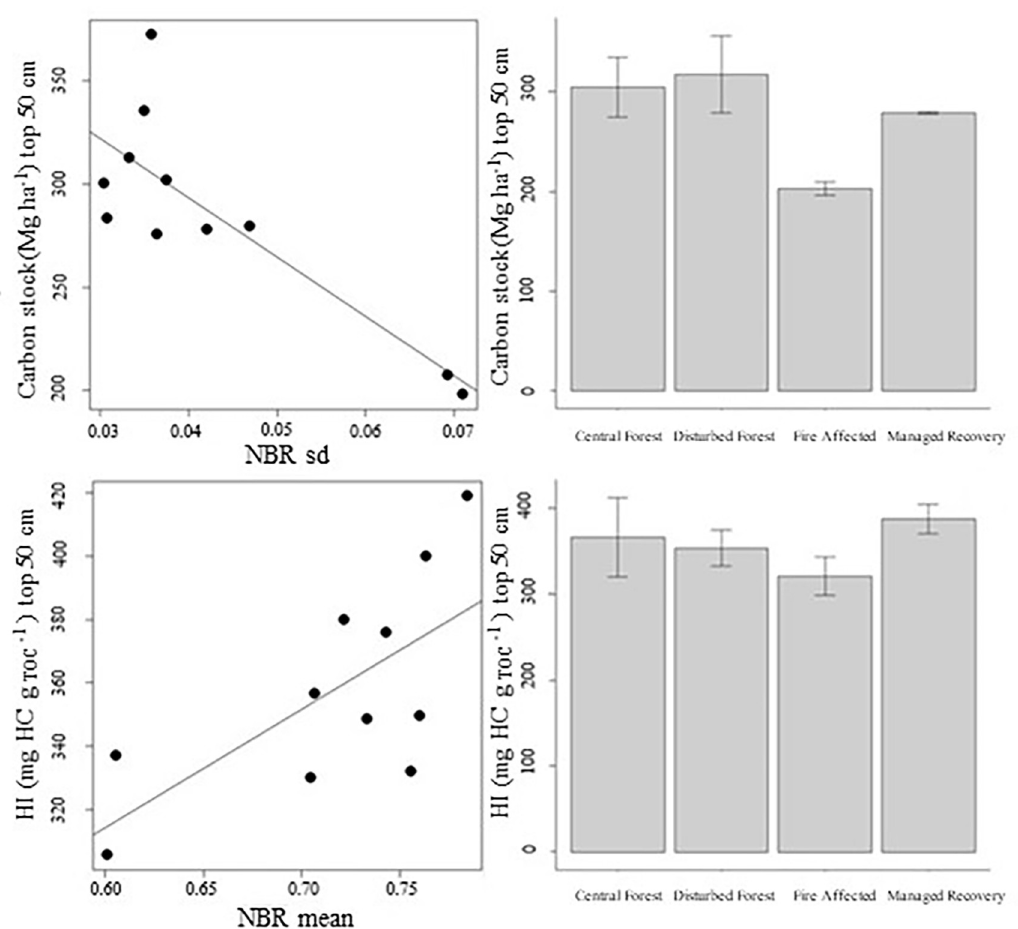
Fig 6. Significant relationships between remote sensing derived products and Rock-Eval pyrolysis parameters: (top left) correlation with Normalised Burn Ration Standard deviation (sd) and Carbon Stock held in the top 50 cm; (top right) Carbon stock held in top 50 cm mean values and SEM for the four forest condition classes; (bottom left) correlation with Normalised Burn Ration mean and HI for the top 50 cm; (bottom right) HI for the top 50 cm mean values and SEM for the four forest condition